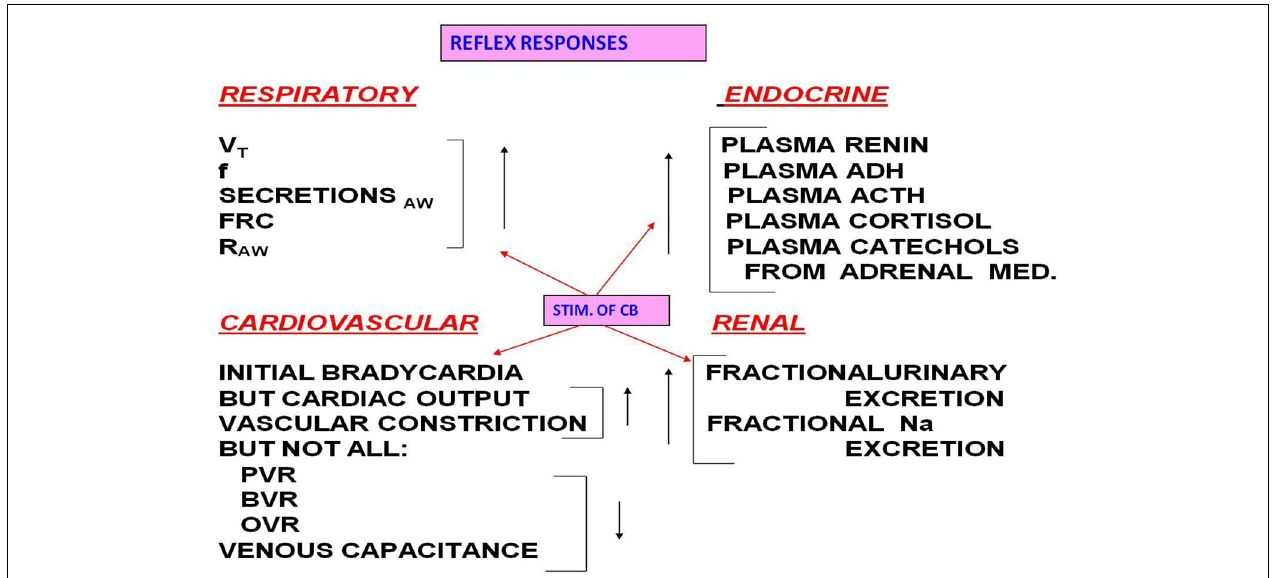
FIGURE 1 | CB stimulation increases the listed variables in the respiratory system. Stimulation increases some CV variables but decreases pulmonary vascular resistance (PVR), bronchial vascular